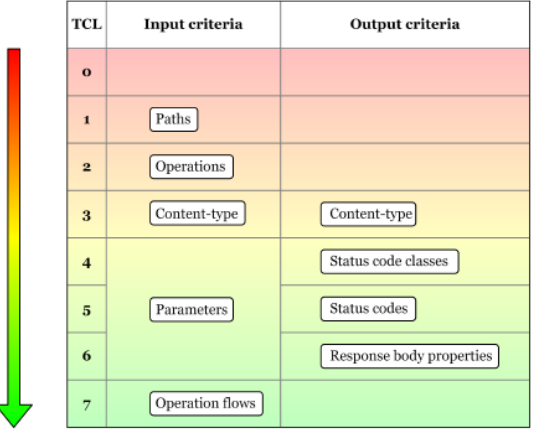
Figure 2. Test Coverage Model: Levels and Criteria [7].